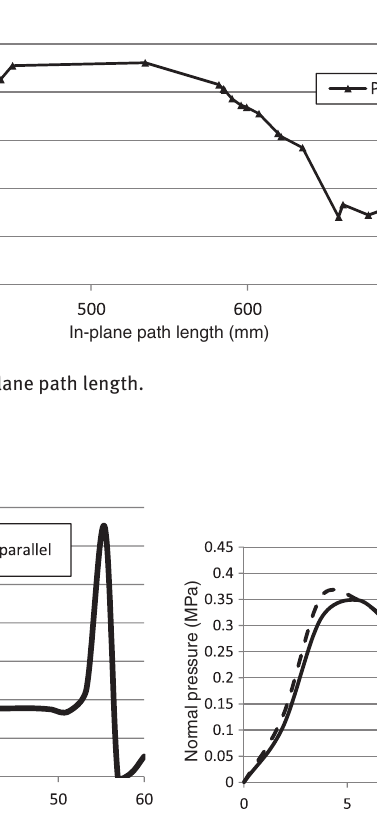
Figure 35 Simulated slit-tape pretension influence on the normal pressure orthogonal to roller